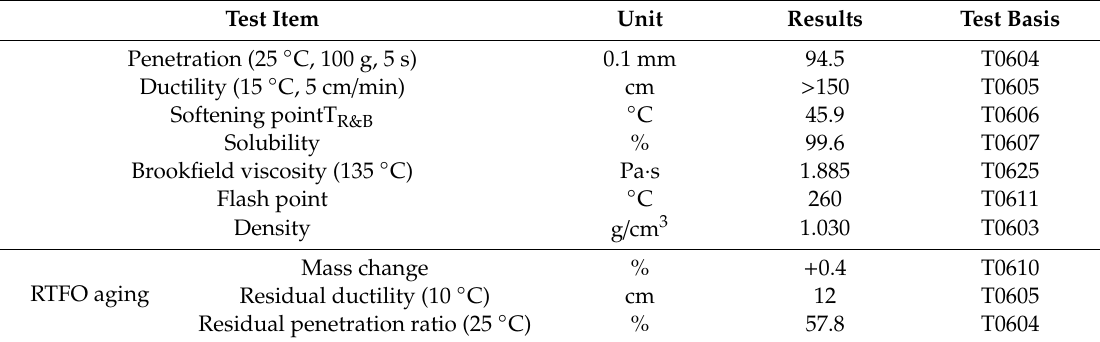
Table 1. Technical indices of SK-90 # bitumen.